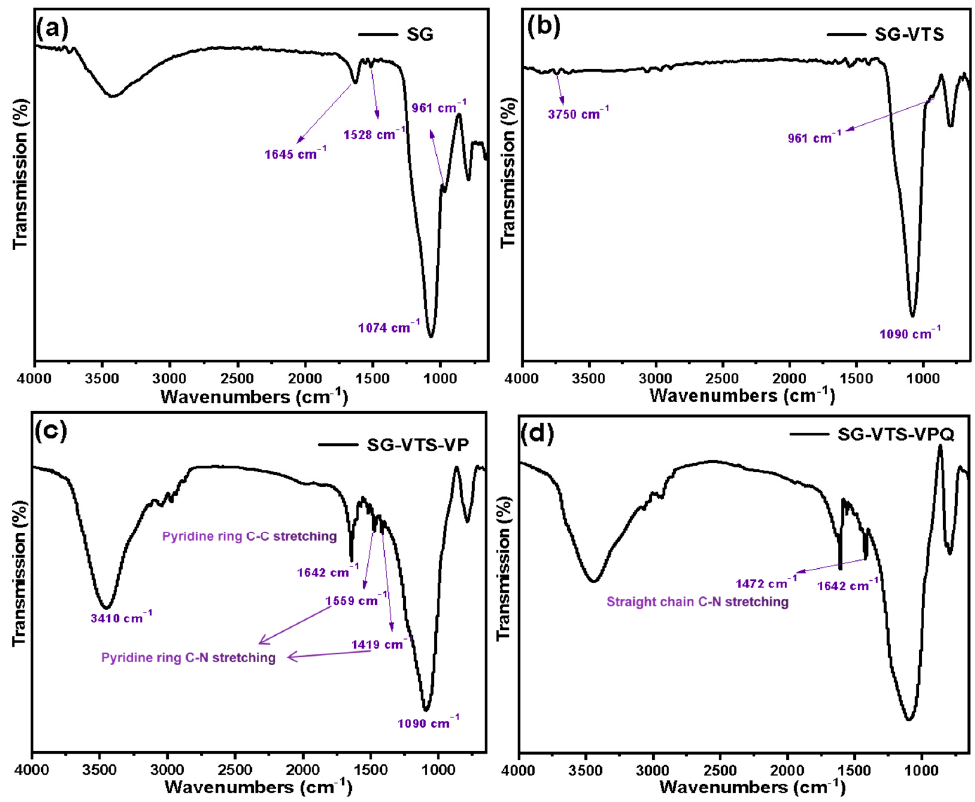
Figure 4. FTIR spectra of the SG ( a ), SG-VTS ( b ), SG-VTS-VP ( c ) and SG-VTS-VPQ ( d